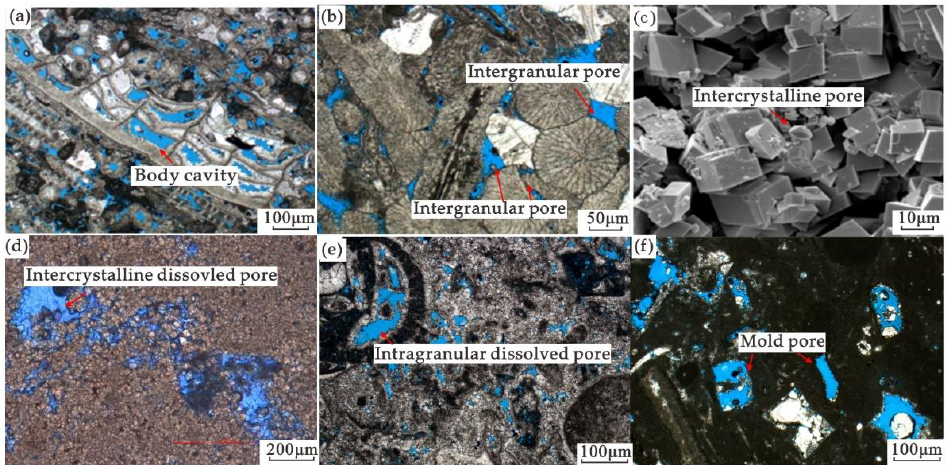
Figure 5. Thin section photos of different pore types in North Truva Oilfield ( a ) Well 5598, 3154.41 m, grainstone, with coral cavity pores; ( b ) Well 5555, 3177.03 m, grainstone, with mainly intergranular pores; ( c ) Well CT-4, 2344.77 m, graindolomite with intercrystalline pores; ( d ) Well A-7, 2669.76 m, crystalline dolomite, with intercrystalline pores and intercrystalline dissolved pores, residual grain shape (yellow arrow) after the dolomite grains are dissolved, and the asphalt half fills the pores; ( e ) CT-22 well, 2354.62 m, packstone, with more intragranular dissolved pores and poor connectivity; ( f ) Well CT-41, 2416.12 m, graindolomite, salt mold hole and grain mold hole are seen.